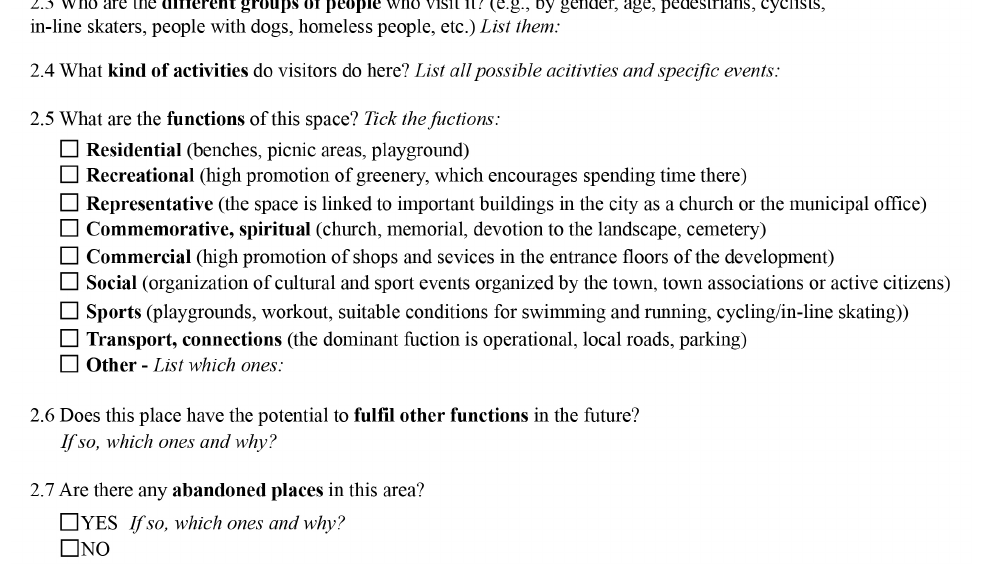
Figure 4. Sample of the on-site public space assessment